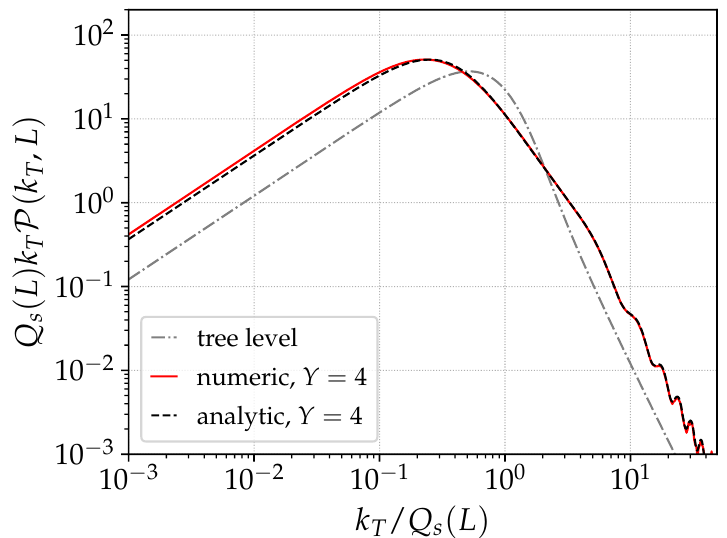
Figure 4. The numerical and analytic TMB distribution after running coupling evolution obtained from the asymptotic study performed in this paper. The wiggles at large k T /Q s ( L ) visible in both numerical and analytical curves are due to the Fourier transform of a non-twice differentiable S - matrix as a function of x T . The value of Y = ln( L/τ 0 ) is Y = 4 . The grey curve is the tree-level distribution, for comparison. The latter is obtained by using eq. (2.7) inside the dipole S